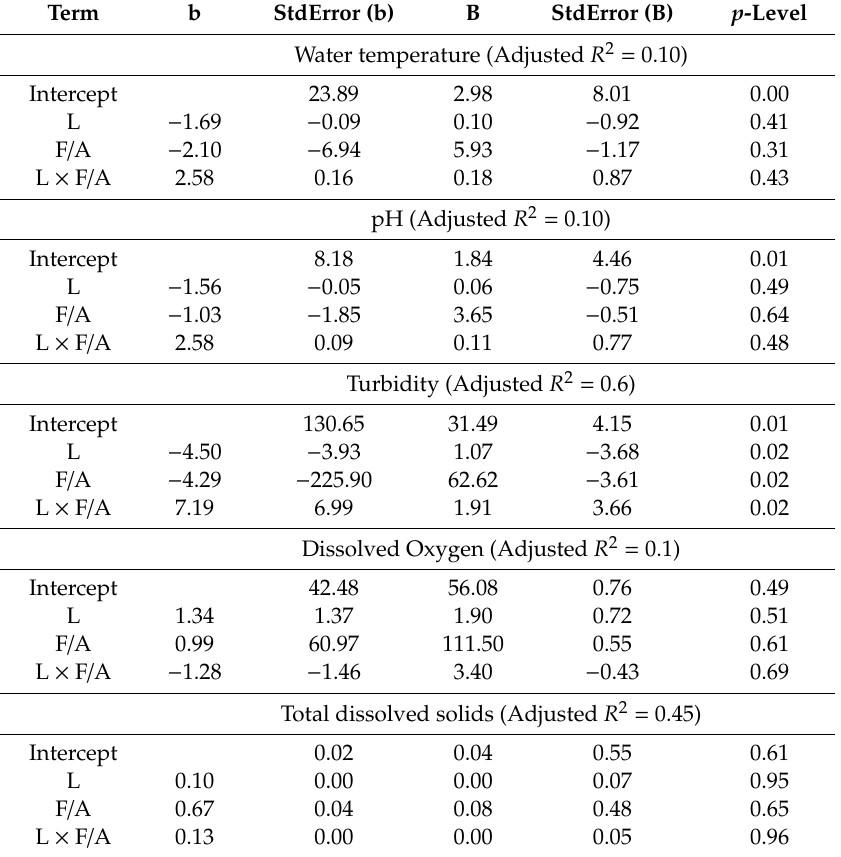
Table 5. Results of multiple regression model. In this run, the formation parameters of IWQ were used as dependent variables, namely water temperature, pH, turbidity, dissolved oxygen and total dissolved solids. The significant values ( p -level ≤ 0.05) are represented in